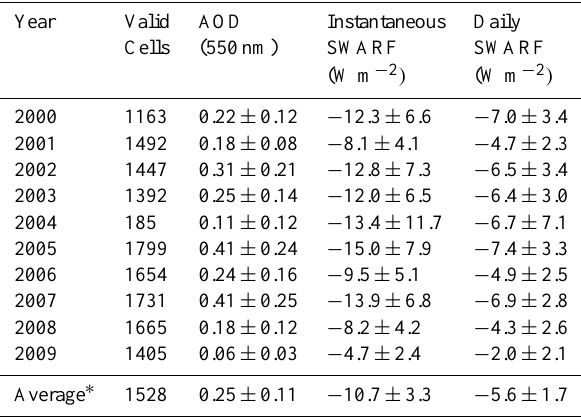
Table 3. Mean aerosol optical depth (AOD), instantaneous short- wave aerosol radiative forcing (SWARF) and daily SWARF for the Amazon region with their respective standard deviation. These cal- culations were performed for the biomass burning season of the years 2000 to 2009. The standard deviation represents the spatial variability of each